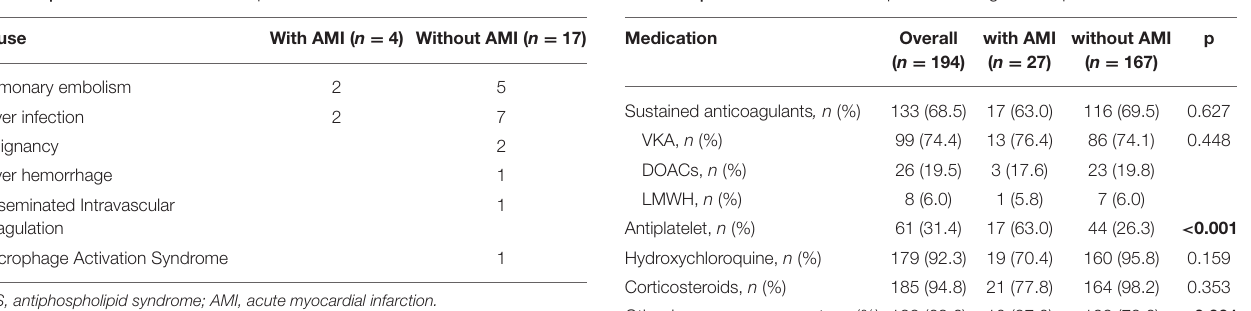
TABLE 5 | Cause of death in 21 APS patients. TABLE 6 | Medication of 194 APS patients during